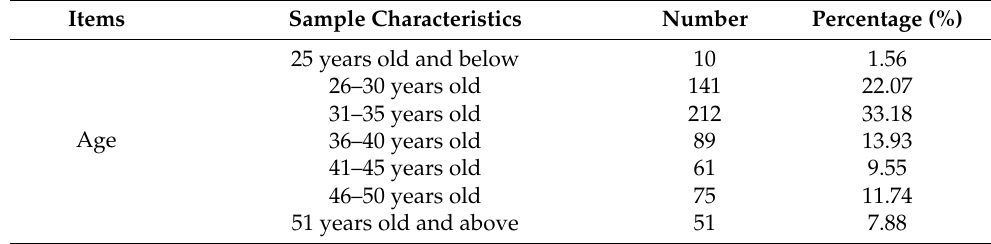
Table 1. Demographic information of coal